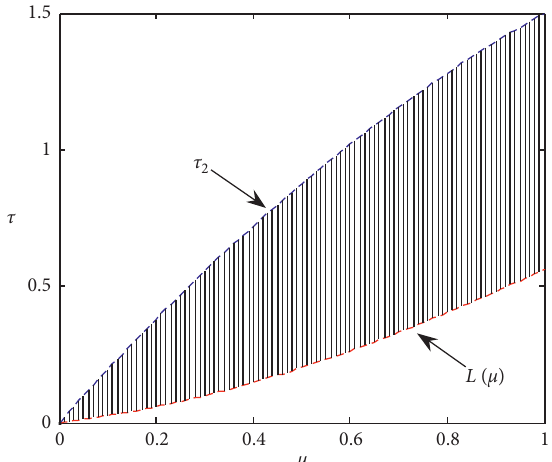
Figure 1: Profitable downward extensions with unique